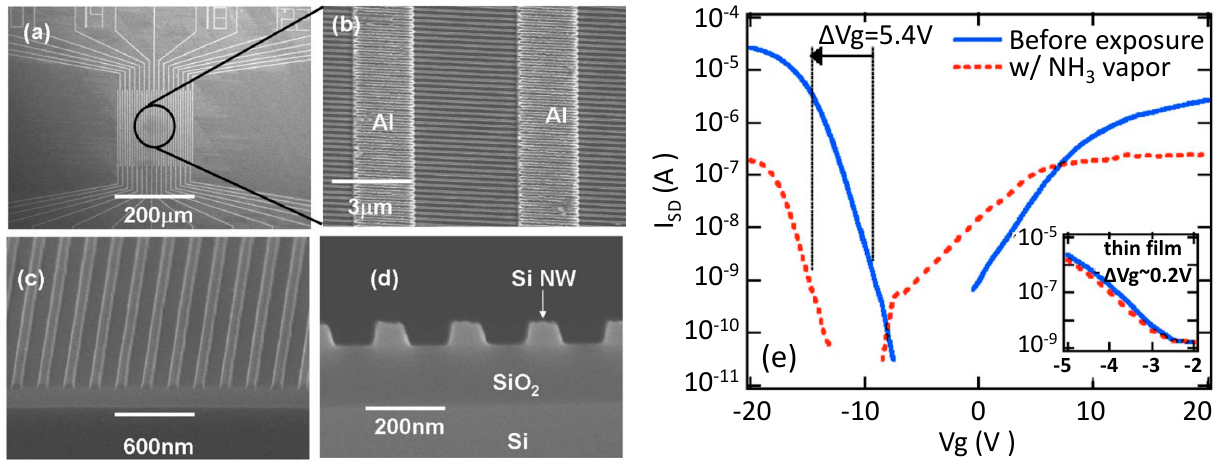
Figure 11. ( a ) Top-down image of one Si nanowire device with interdigitated Al source and drain electrodes. ( b ) Close-up SEM image, the dense, well-arranged Si nanowire channels were connected with two Al electrodes. Cross-sectional SEM images at ( c ) 60° and ( d ) 90° tilt. ( e ) Channel current vs. gate voltage curves before and after NH a negatively shift of the threshold voltage of about 5.4 V was obtained after NH for comparison, the inset shows that the SOI thin film device has much smaller threshold voltage shift. Reprinted from reference [96] with permission from AIP